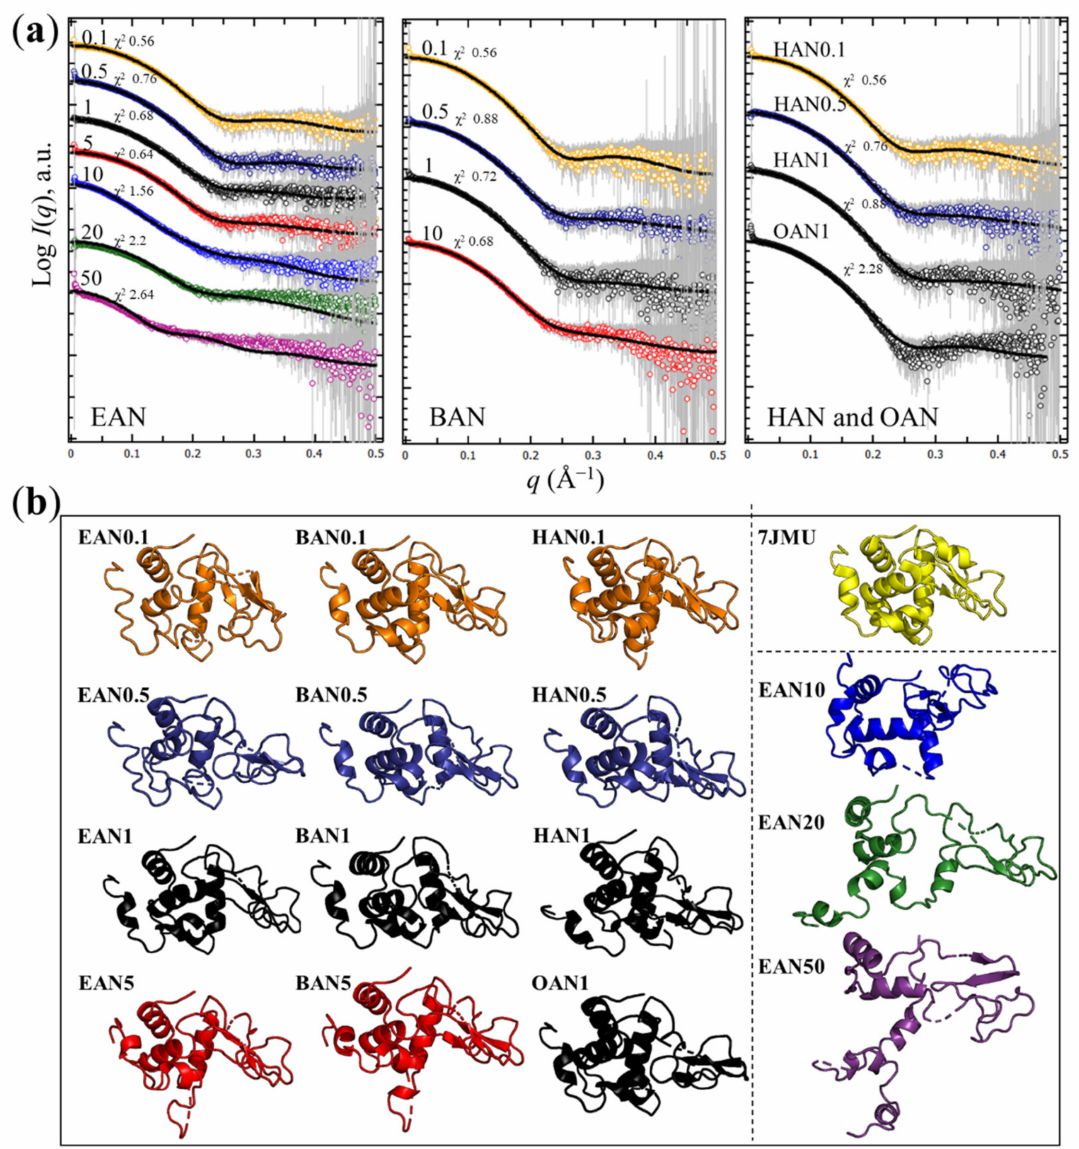
Figure 6. ( a ) SREFLEX fits of SAXS data of lysozyme in PIL-water mixtures (EAN, BAN, HAN and OAN with concentration (mol%) provided), where the solid line refers to the fitting after SREFLEX refinement. The refined model was selected based on the χ 2 values closest to 1.00 which indicates the best fit, and the values are included on the plots. ( b ) The resulting SREFLEX models of lysozyme in PIL-water mixtures at different PIL concentrations (mol%), and the initial crystal structure of lysozyme (yellow, PDB